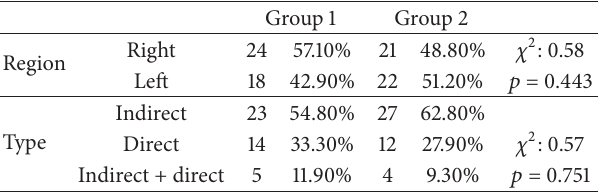
Table 2: Distribution of region and type.